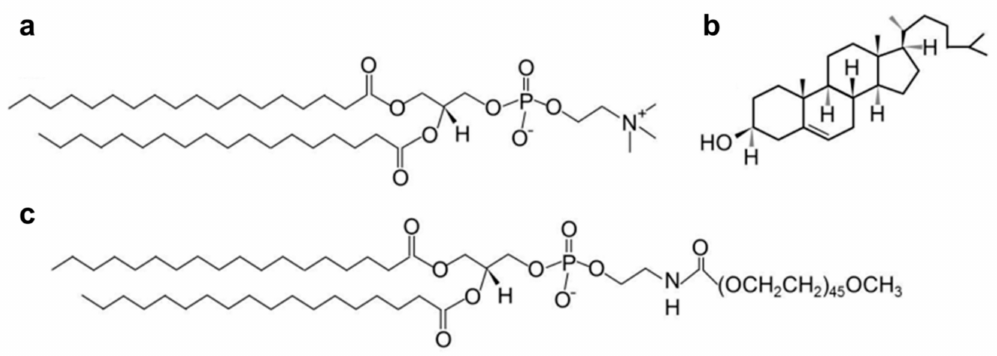
Figure 6. Structures of common liposomal constituents: ( a ) 1,2-distearoyl-sn-glycerophosphocholine (DSPC); ( b ) cholesterol; ( c ) 1,2-distearoyl-sn-glycero-3-phosphoethanolamine polyethylene glycol (DSPEPEG)